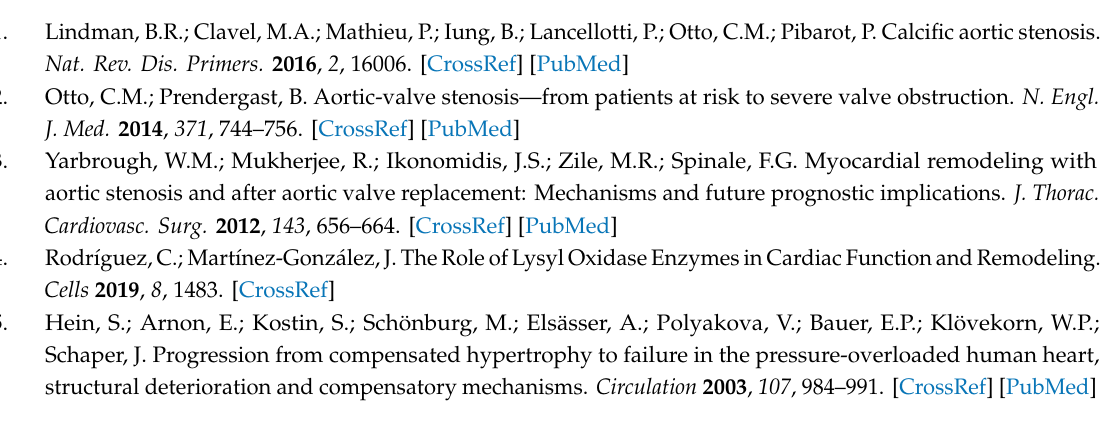
Figure S1: Mean trans-coarctation gradients determined by Doppler echocardiography 4 weeks after transverse aortic constriction (TAC); Figure S2: Percent change of morphological and functional echocardiographic parameters in male and female mice 4 weeks after TAC versus basal condition; Figure S3: Linear regression and Pearson’s correlation analyses between miR-29b expression in the LV and plasma with age in control patients of any